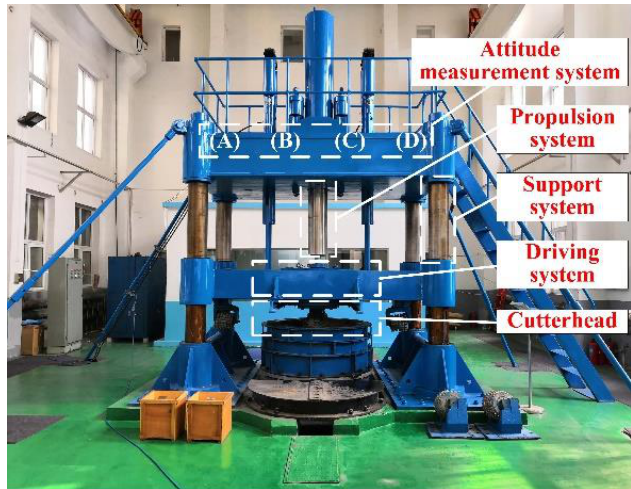
Figure 10. Experimental platform of attitude measurement system.